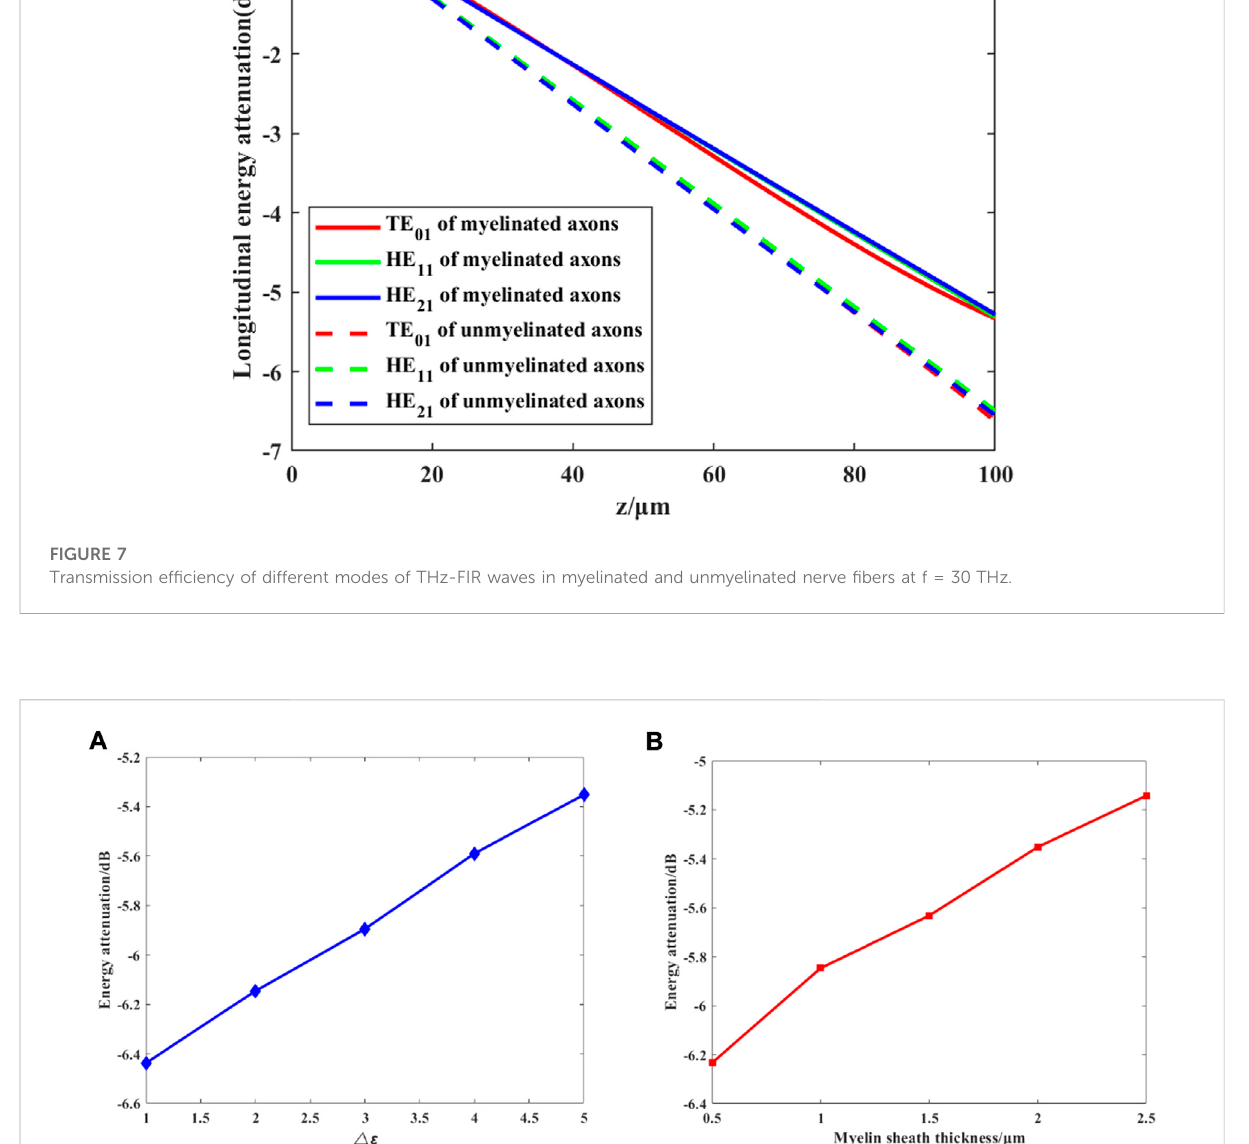
method. At f = 12.5 THz, S11 has the minimum value. This indicates that the re fl ection of THz-FIR transmission is the smallest at this time, which is mainly related to the width of the nodes of Ranvier. At the same time, S21 is greater than − 5dB, which indicates that the THz-FIR wave has good transmission